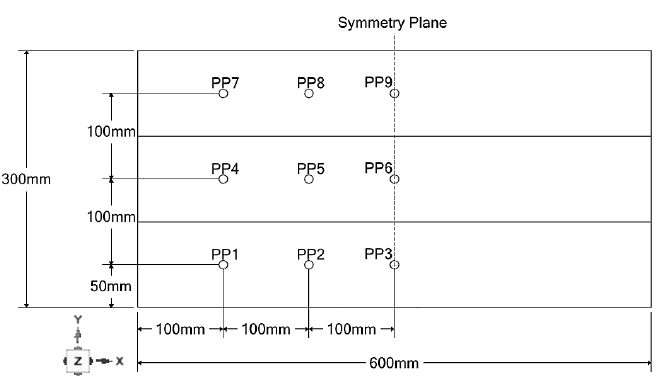
Figure 11. Arrangement of pressure measurement points for performance analysis of various break- water designs.